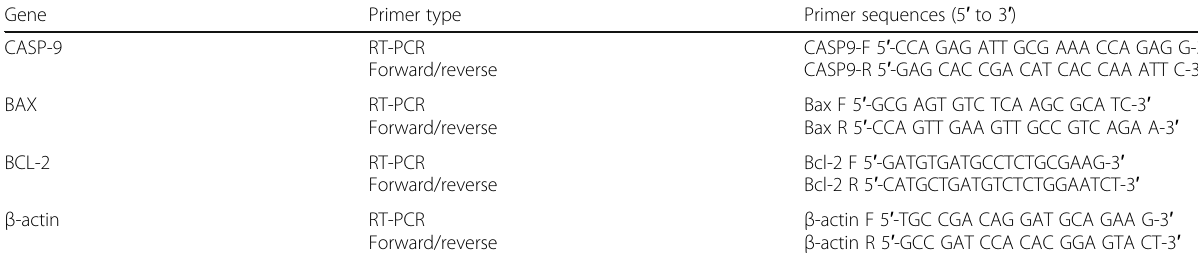
Table 1 Primers sequence for all studied genes in the work Gene